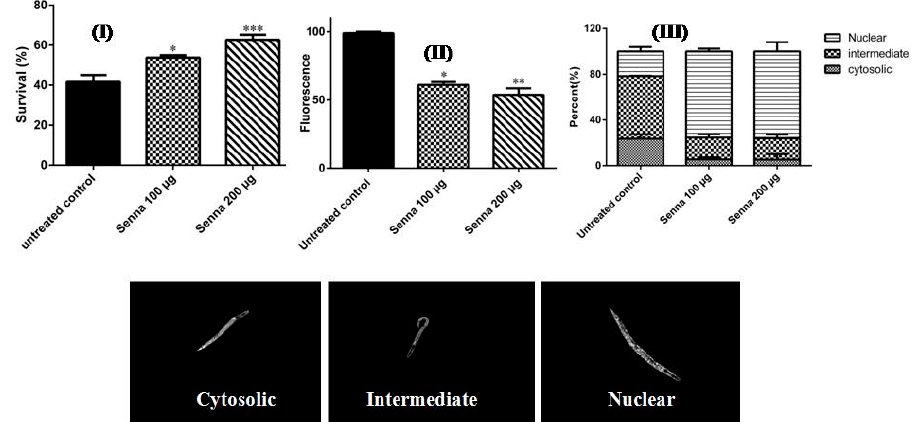
Figure 3. ( I ) Protective effects in N2 worms pre-treated with S. singueana on the survival rate of wild-type nematodes treated with a lethal dose of 80 µM juglone. Significant increase in the survival rate was observed after the worms were pre-treated with the extract. Data are presented as percentage of survival (mean ± SEM, n =3)’ ( II ): Intracellular ROS levels in wild-type N2 nematodes evidenced by the fluorescence H2DCF-DA dye. Results are presented as relative fluorescent intensity related to control of the mean ± SEM of three individual experiments in which at least 20 worms were analyzed. The accumulation of mitochondrial ROS was significantly diminished when worms were pre-treated with the extract ( III ): Effects of the root extract on the translocation of DAF-16 transcription factor in mutant TJ356 strains. Subcellular localization of DAF-16:GFP was analyzed by fluorescence microscopy (200 × ) and the nematodes were sorted to the categories cytosolic, intermediate, and nuclear according to their localisation phenotype as shown in the representative images.* p < 0.05, ** p < 0.01,*** p < 0.001 related to control was analysed by one-way ANOVA.